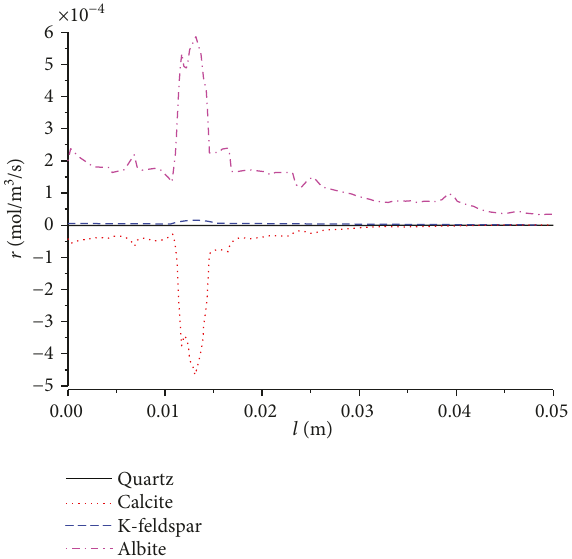
Figure 16: Rates of di ff erent chemical reactions along transect 1 ( t = 2000